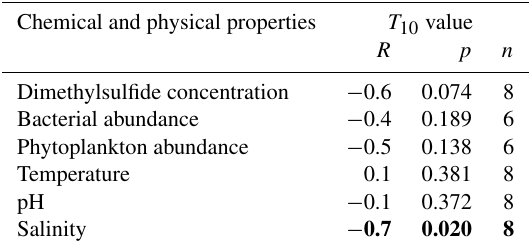
(15 mW output; blue), using Expo32 v1.2b software (Beck- man Coulter).